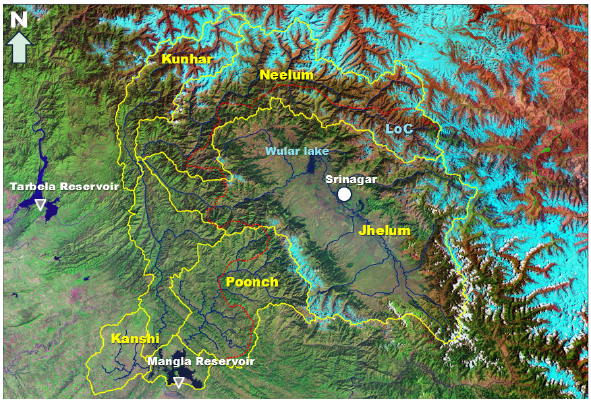
Figure 2. Distribution of monthly inflow to Mangla reservoir 2000–